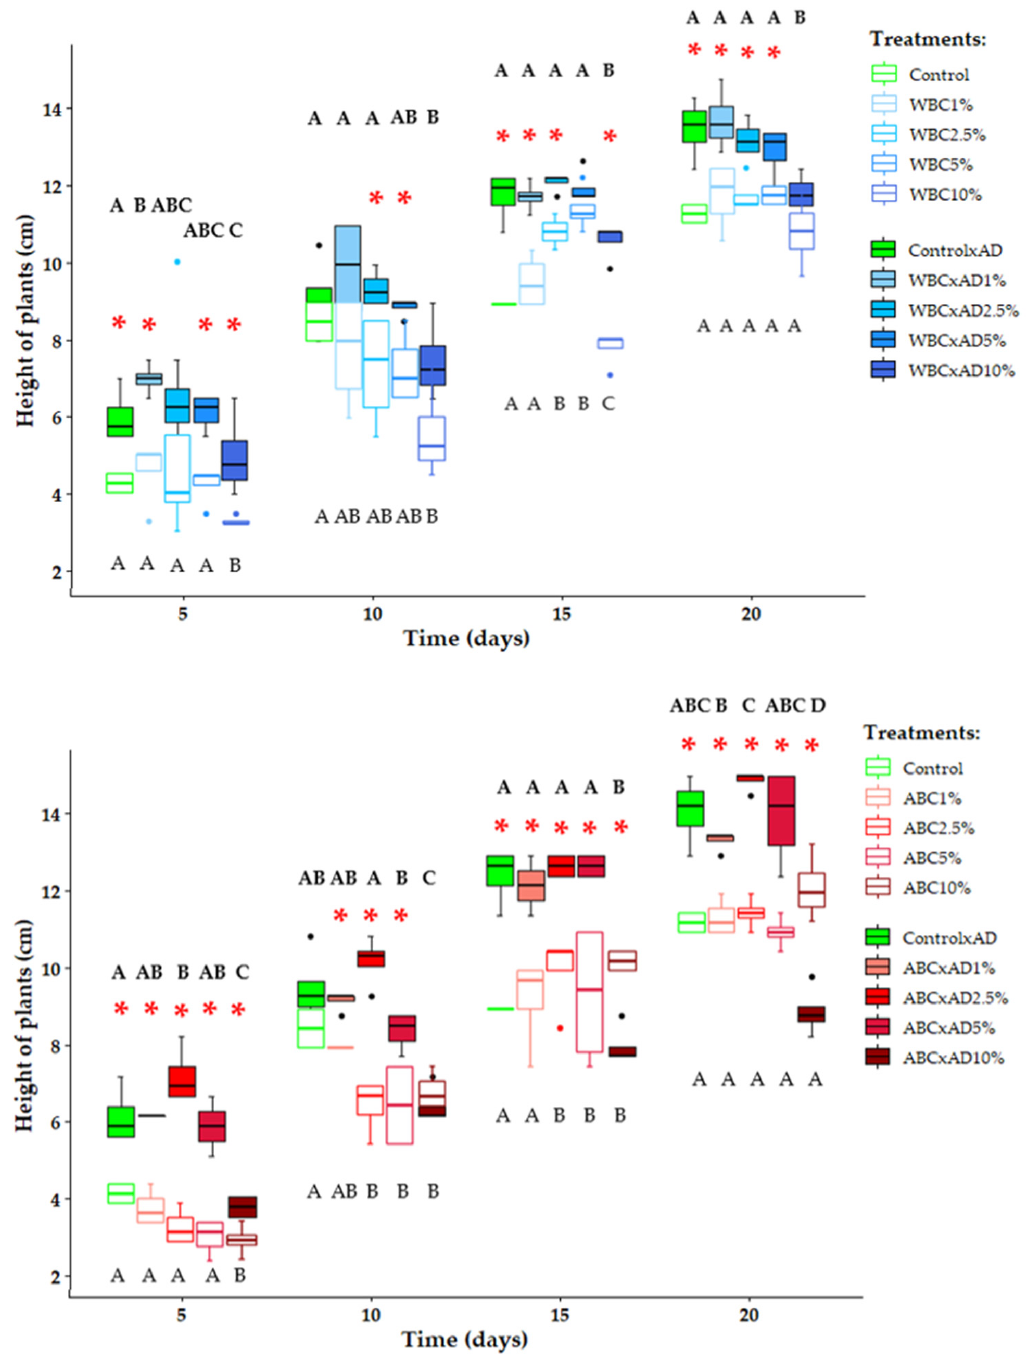
Figure 2. Effects of different biochars (WBC: wood chip biochar; ABC: animal bone biochar) and combined biochar–digestate (WBCxAD, ABCxAD) treatments on the growth of ryegrass ( Lolium perenne ) on selected days of the growing period. C: control without biochar supplemented with or without digestate. Numbers after the treatment codes indicate application rates of biochars as the following: 1%, 2.5%, 5%, and 10% application rates, respectively. Different letters on the same test day indicate significant differences between groups, and the bold letters belong to the digestate- supplemented treatments (ABCxAD and WBCxAD) in each case. Asterisks indicate significant differences between treatments on the various test days and application rates ( p < 0.05) without or in the presence of the digestate.